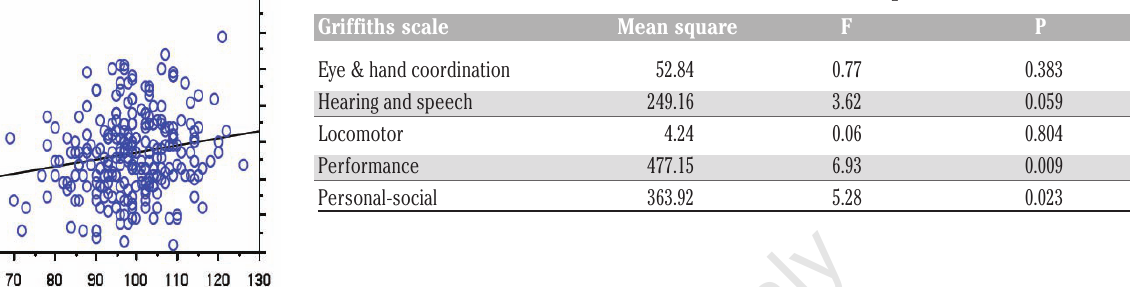
Table 3. Results of ANOVA of Griffiths scales with WPPSI-R performance IQ.